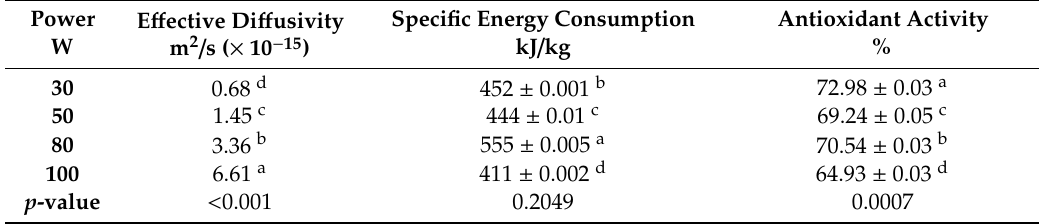
Table 2. Effect of microwave power on effective diffusivity, energy consumption and antioxidant activity.